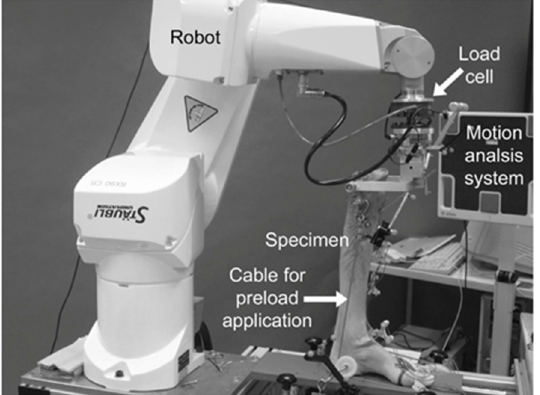
Figure 2. Robotic cadaver testing displayed with robot, specimen, and motion analysis system. The specimen is mounted to the robot and equipped with ultrasound transducers. Reprinted with permission from [16]. Copyright 2007 BMC.